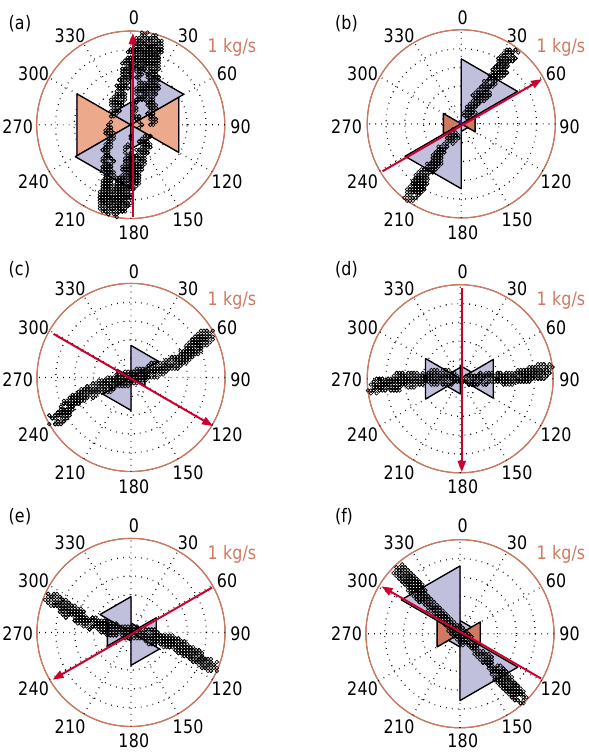
Fig. 6. (a–f) Instantaneous distributions of azimuthal magnetopause mass transfer at angles indicated by dashed vertical lines in Fig. 5, which presents the time evolution of net transferred mass for all runs. Blue (red) color indicates inward (outward) mass at magne- topause in sectors shown outside the outer circle. The sectors scale from 0kgs − 1 at the centre to 1kgs − 1 at the outer circle. The IMF clock angle direction is indicated by a red arrow, while black cir- cles show the locations where the “four-field junction” condition holds; i.e., where reconnection is likely to occur. Notice that the dayside black circles in panel (a) indicate sunward convection, not reconnection, which occurs behind the cusps (as deduced from the annihilation of magnetic energy). Although the figure is for Run #1, the other runs behave qualitatively